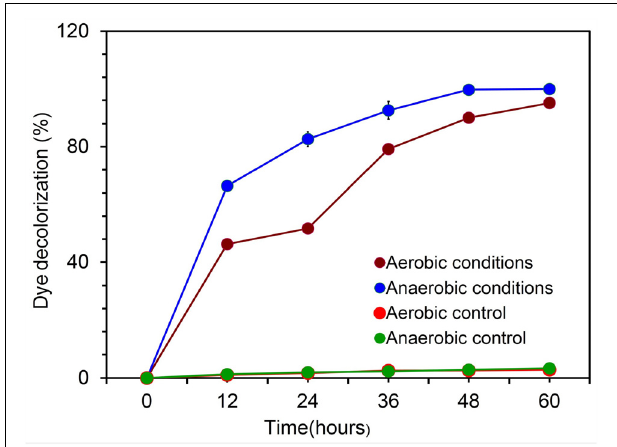
FIGURE 5 | Current production by Citrobacter sp. KVM11 in single chamber MFCs containing brush anodes. Green dotted line shows a representative cycle of current production in acetate (1g/L) fed MFCs; Blue dotted line shows a representative cycle of current production in citrate (1g/L) fed MFCs; Red dotted line shows a represntative cycle of current production in diesel range hydrocarbons (DRH) (800mg/L). to degrade PH, (ii) dye detoxification in MERS, and (iii)